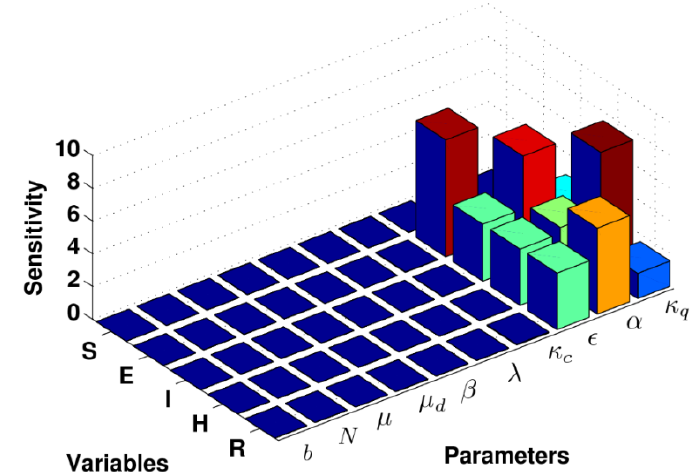
Figure 6. Local sensitivity analysis with full-normalization technique of all variables with respect to all parameters in computational simulations using